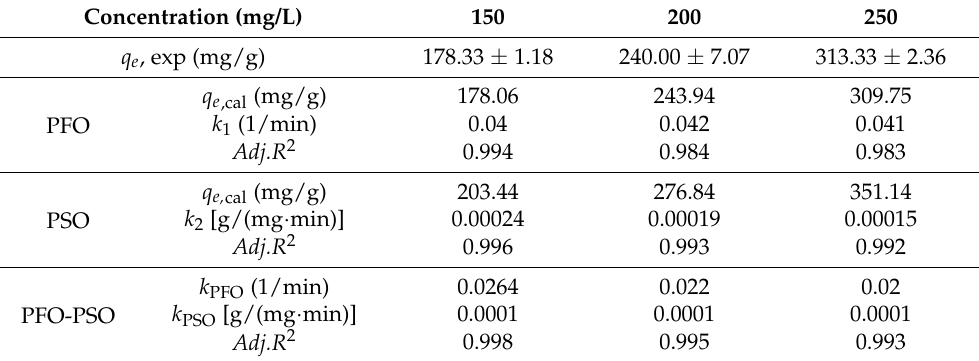
Table 4. Kinetic parameters of colorant adsorption by BBC-HAP (adsorbent dosage, 0.75 mg/mL; pH, 7; and temperature, 300